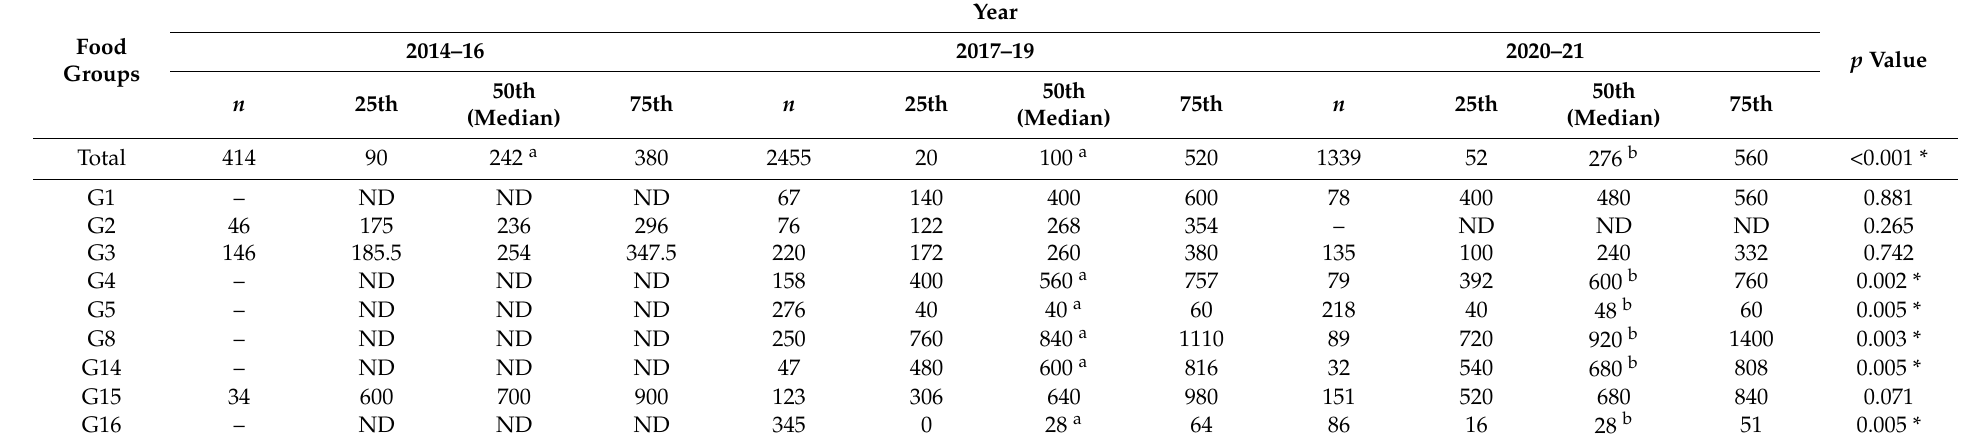
Table 5. Comparison of the sodium content (mg/100 g food) by group and